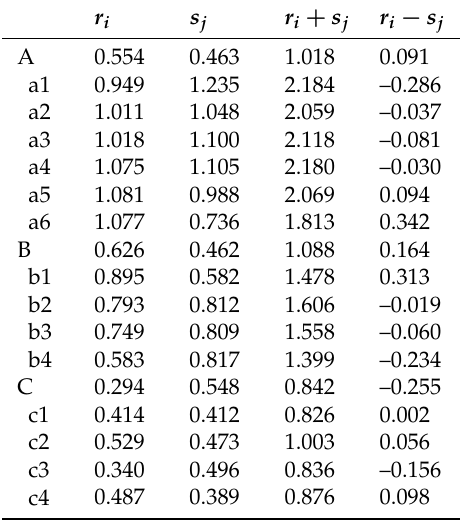
Table 11. Sum of influences given and received by dimensions and